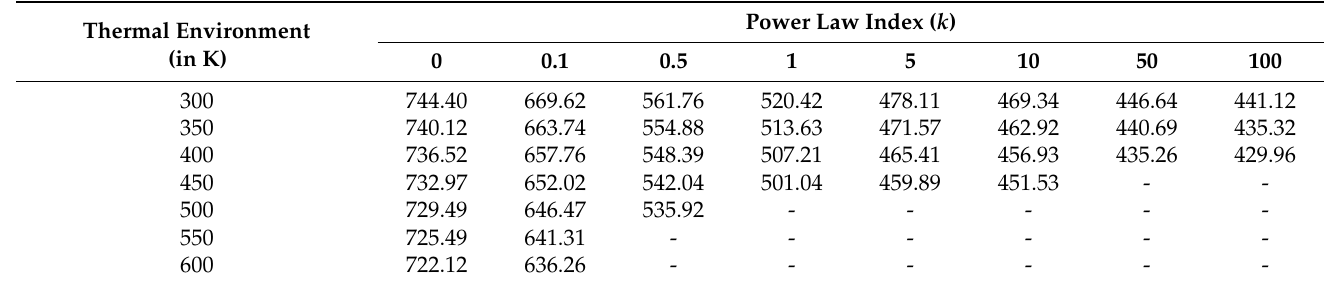
Effect of a uniform thermal field on critical buckling temperatures (in K) of an alu- minum/aluminum oxide FGM shell for different material composition in re-entry vehicle nose structures.